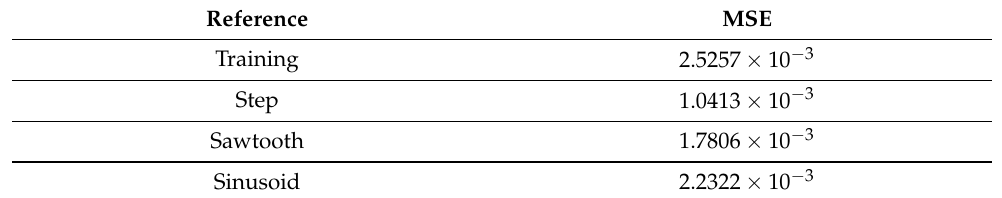
Table 12. MSE obtained by the reference model controller for the different signals.